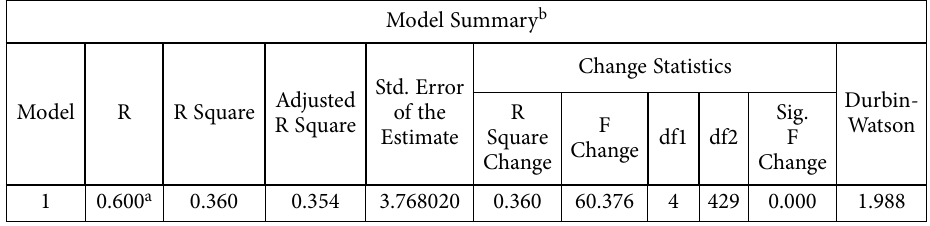
Table 2. Model summary and ANOVA (global) (source: own construction by using SPSS) Model Summary